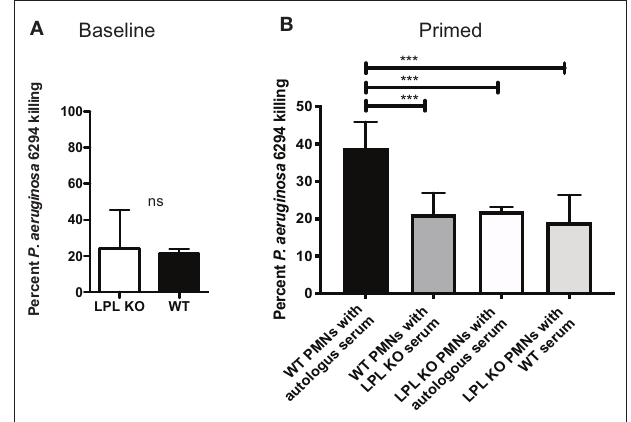
FIGURE 7 | L-plastin deficient PMNs show diminished bactericidal activities. (A) LPL-deficient and sufficient neutrophils were purified from bone marrow and exposed to P. aeruginosa at MOI of 0.05. No differences in the bactericidal activities were noted when the reactions were conducted in the presence of autologous serum. (B) LPL-deficient show compromised bactericidal activity against P. aeruginosa. OPK assays were carried out with bone marrow derived neutrophils harvested from infected mice in the presence of either autologous serum harvested from WT mice or serum harvested from infected LPL KO mice. Percent killed P. aeruginosa was plotted (One-way ANOVA, overall p = 0.001). Significant differences were denoted by asterisks. Data